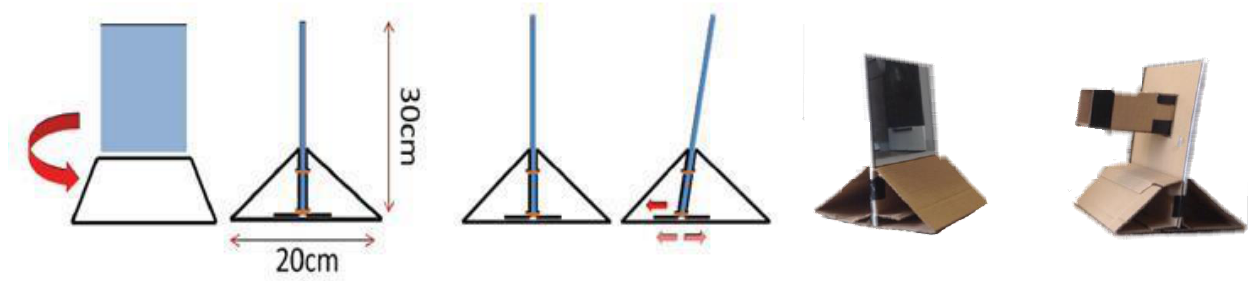
Figure 8 Mirrors and sensor's base, their rotations